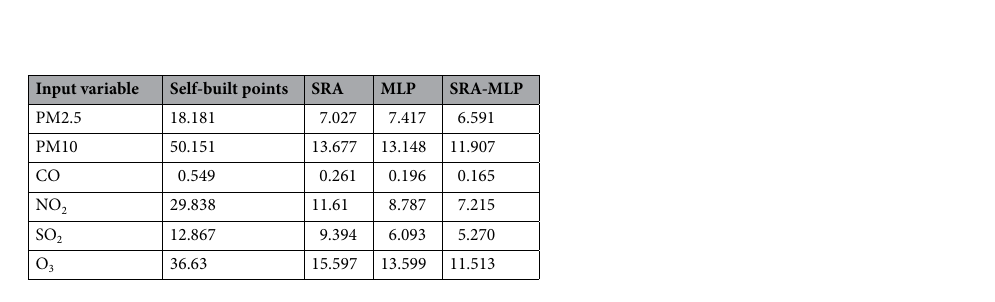
Table 6. MAE of six types of air pollutant concentrations between self-built points, model forecast values and national control point.